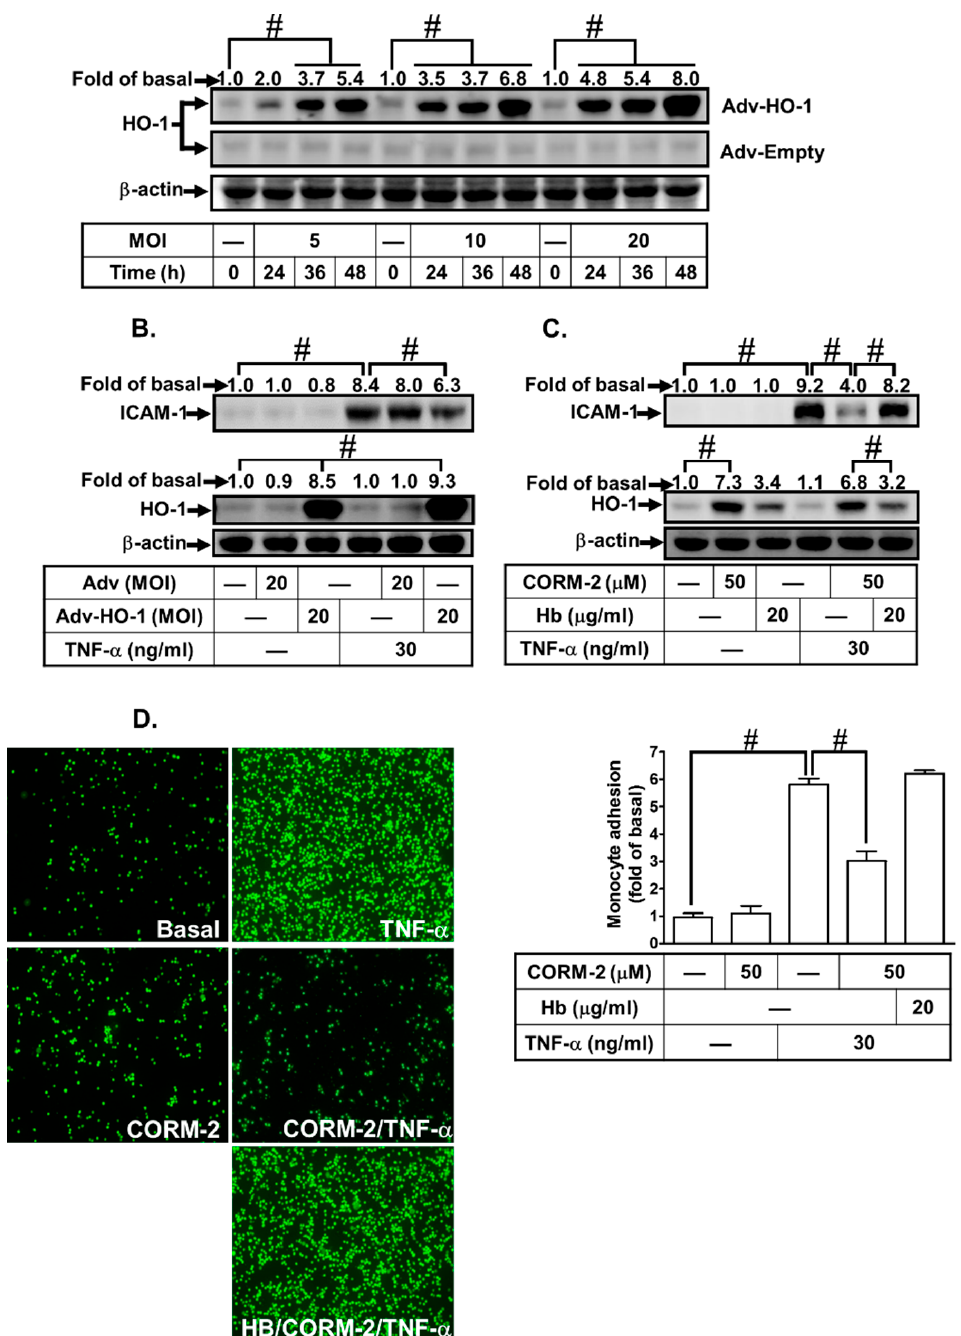
Figure 2. Upregulation of HO-1 suppresses TNF- α -induced ICAM-1 expression on human pulmonary alveolar epithelial cells (HPAEpiCs). ( A ) Cells were infected with an indicated multiplicity of infection (MOI) with either an empty adenovirus (Adv) or Adv-HO-1 for the indicated time intervals. ( B ) HPAEpiCs were infected with 20 MOI of empty Adv or Adv-HO-1 for 36 h, followed by 30 ng/mL TNF- α for 10 h. ( C , D ) HPAEpiCs were pretreated with 20 µ g/mL hemoglobin (Hb) for 1 h and then treated with 50 µ M CORM-2 for 6 h, followed by incubation with 30 ng/mL TNF- α for 10 h. ( A – C ) The levels of HO-1, ICAM-1, and β -actin protein were determined by western blot. ( D ) The adhesion of THP-1 cells was measured. Data are expressed as mean ± SEM, n = 3. # p < 0.01, as compared with the respective groups as